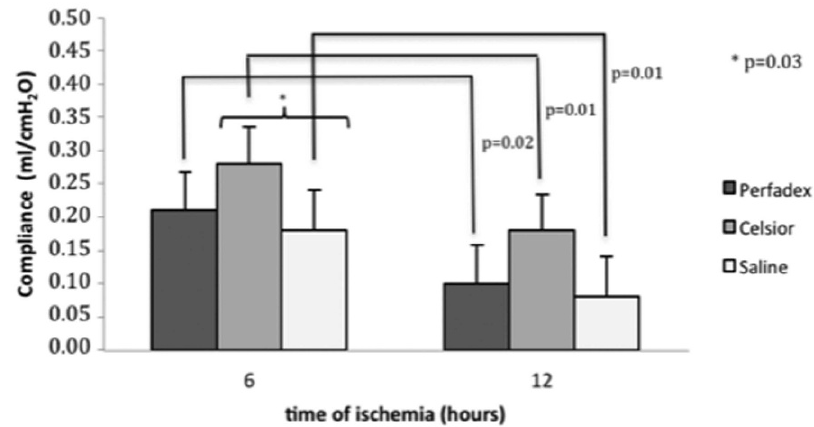
Figure 2 - Mean lung compliance of rat lungs submitted to ischemia and reperfusion for 60 minutes, illustrating no significant differences between lungs preserved with Celsior and Perfadex. Lungs subjected to ischemia for 6 hours performed better than those subjected to 12 hours of